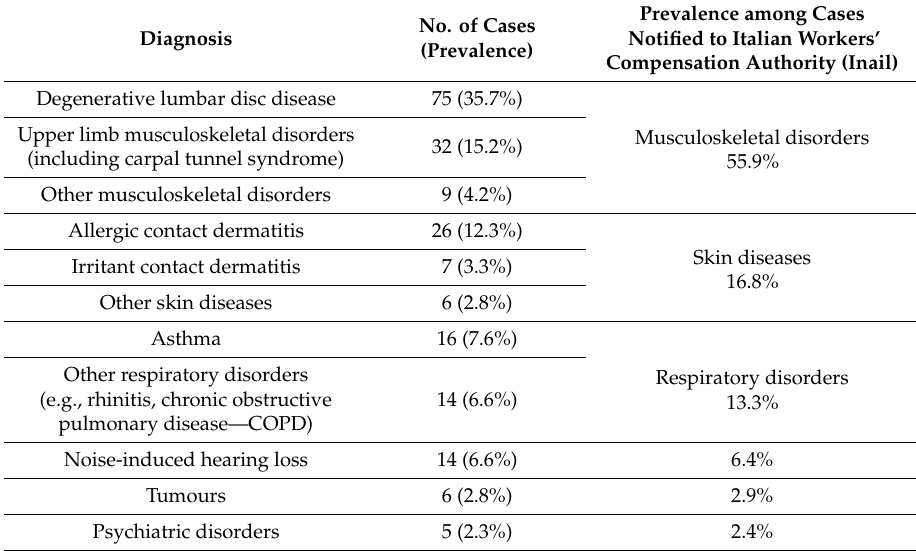
Upper limb musculoskeletal disorders (including carpal tunnel syndrome)